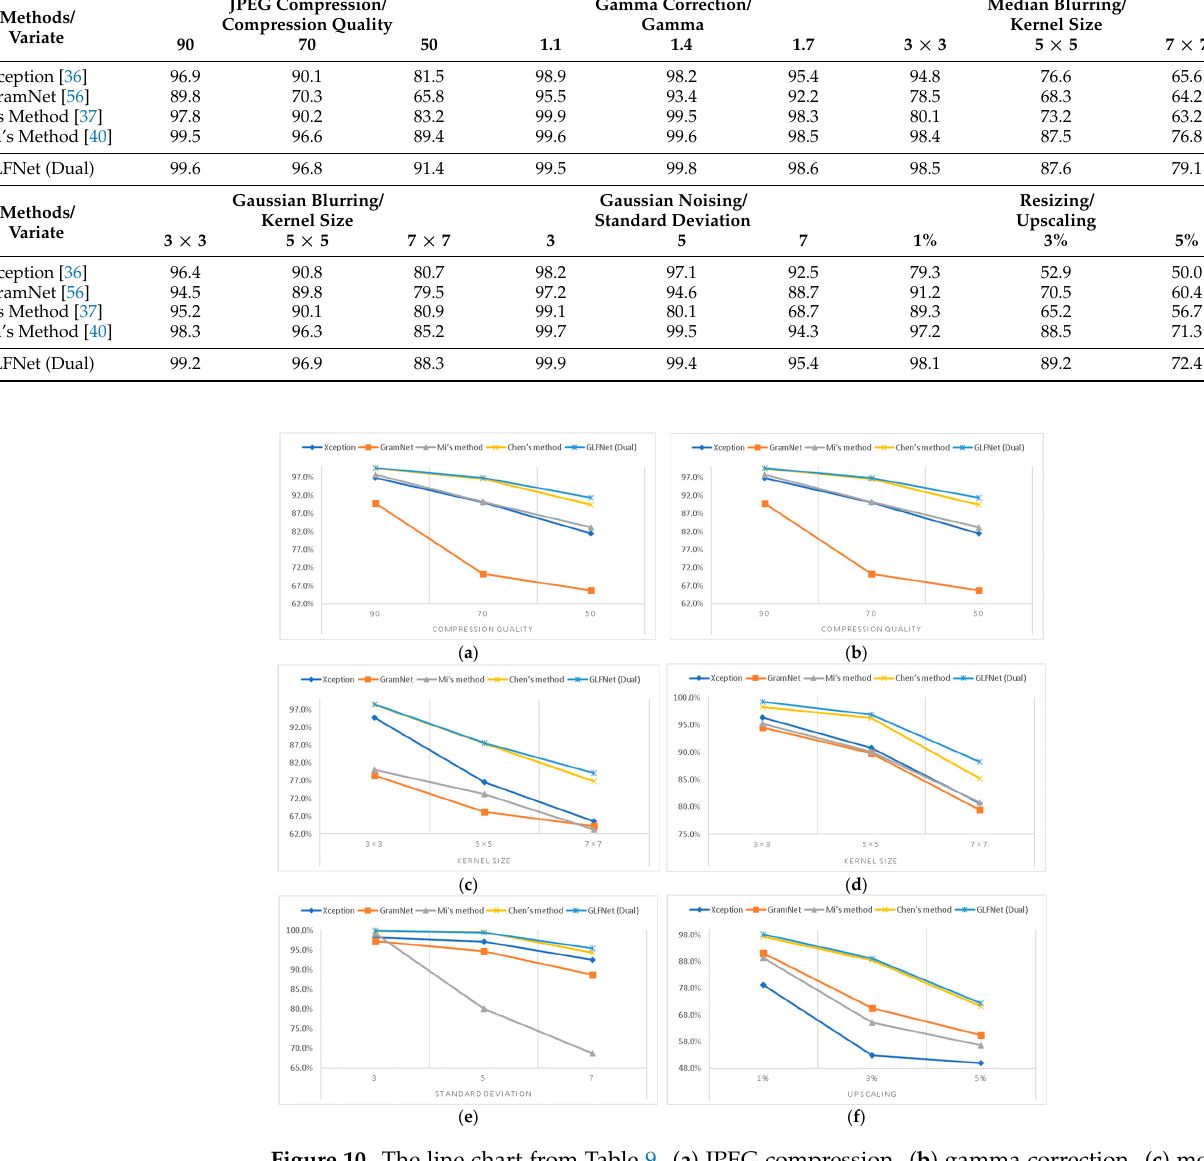
Figure 10. The line chart from Table 9. ( a ) JPEG compression. ( b ) gamma correction. ( c ) median blurring. ( d ) Gaussian blurring. ( e ) Gaussian noising. ( f ) resizing.